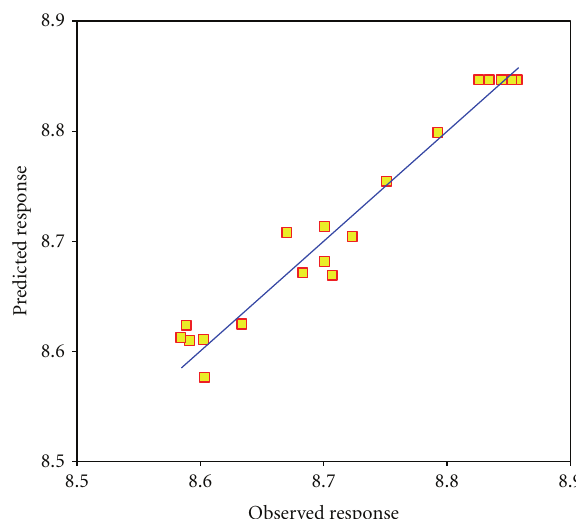
Figure 3: Contour plot for DNS 32 strain production as a function of X 1 (corn flour concentration) and X 2 (soybean concentration) when the coded value of X 3 (K 2 HPO 4 flour concentration) was fixed at